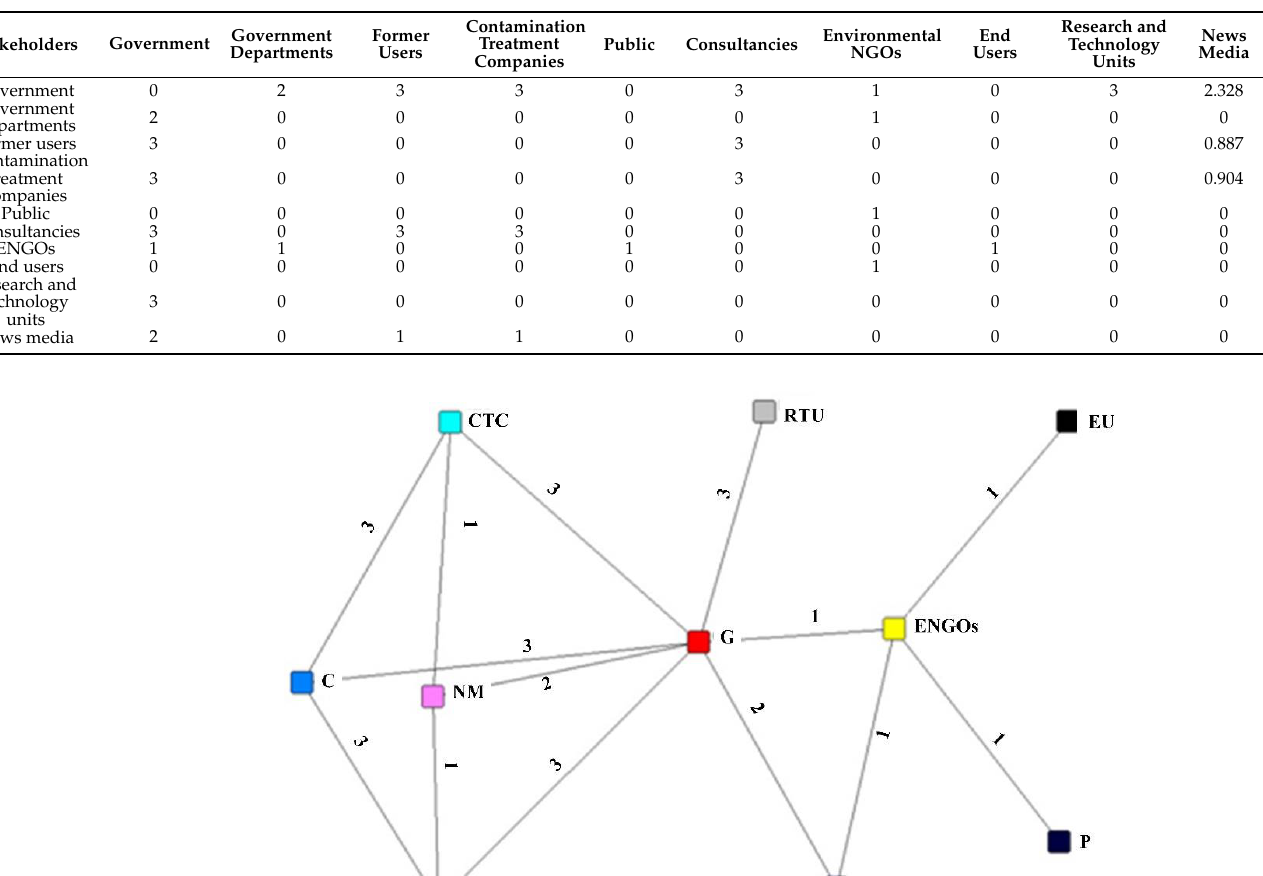
Table 2. Relationship matrix of BR stakeholders at the recycling and contamination treatment stage.